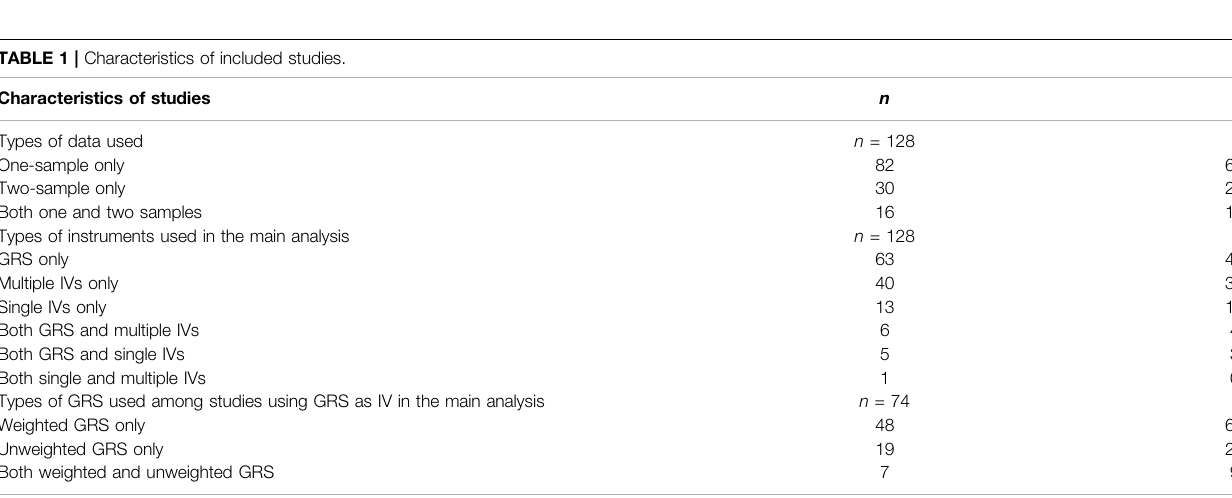
TABLE 1 | Characteristics of included